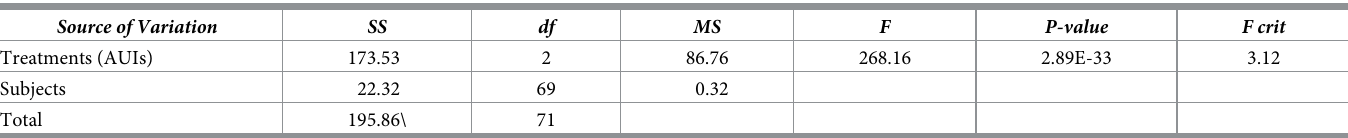
Table 20. One-way ANOVA—Viewpoint #6. Source of Variation SS